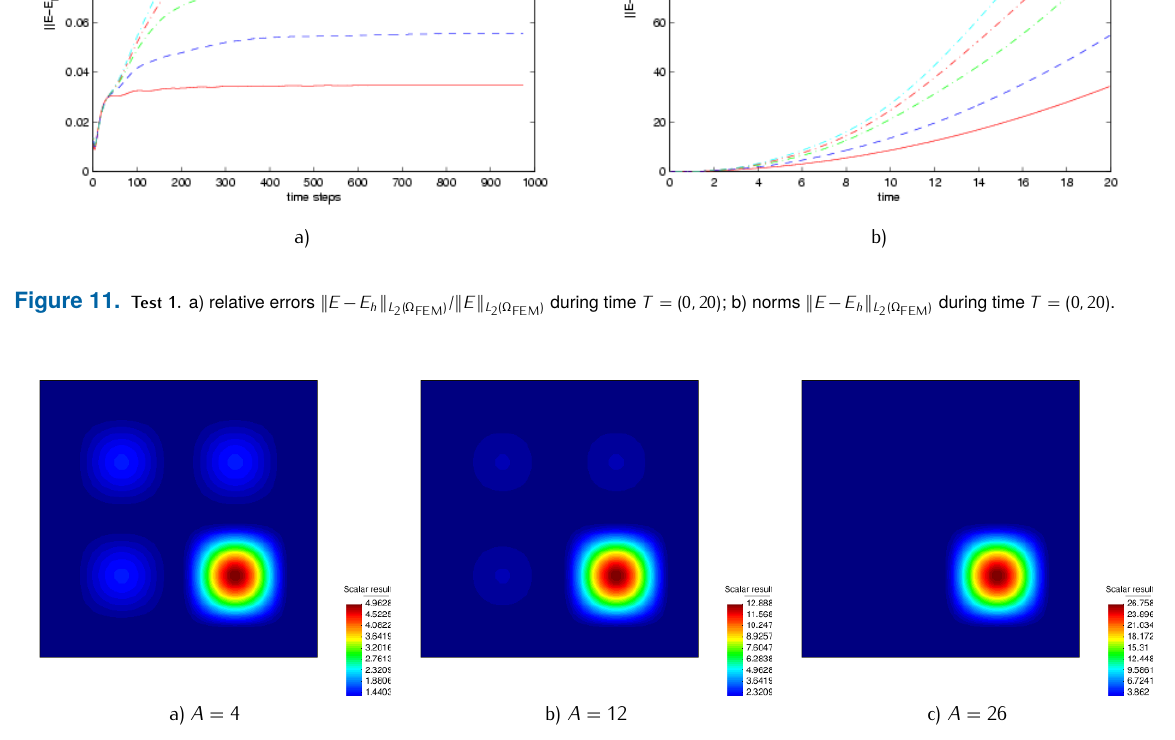
Figure 12. Different coefficients ε ( x ) defined by (53) used in tests with a plane